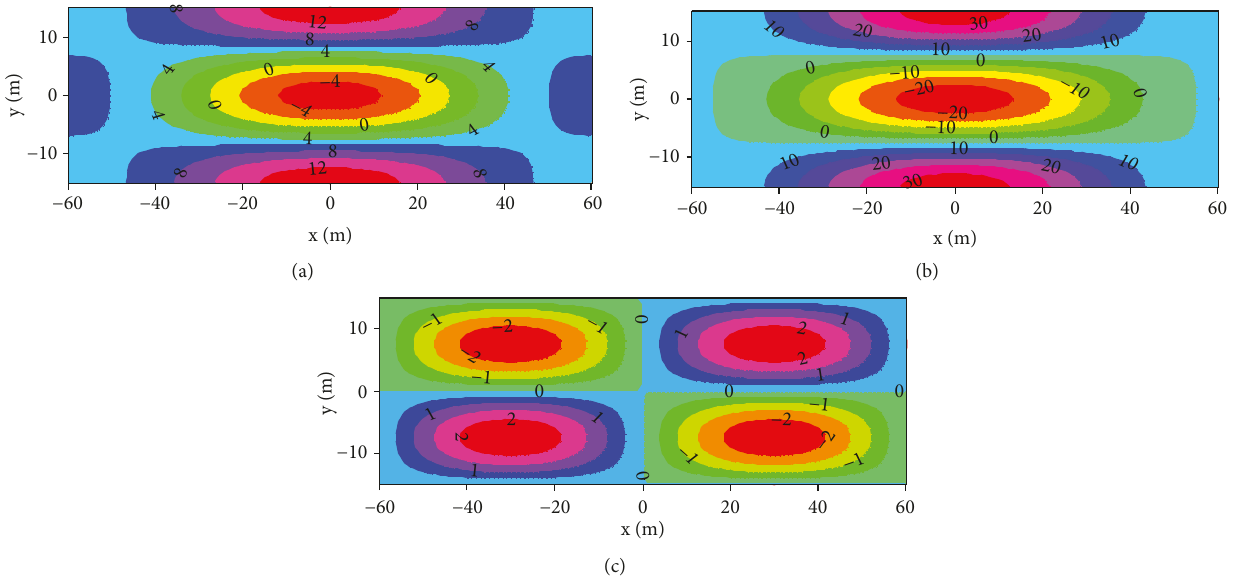
σ y . (c) Distribution